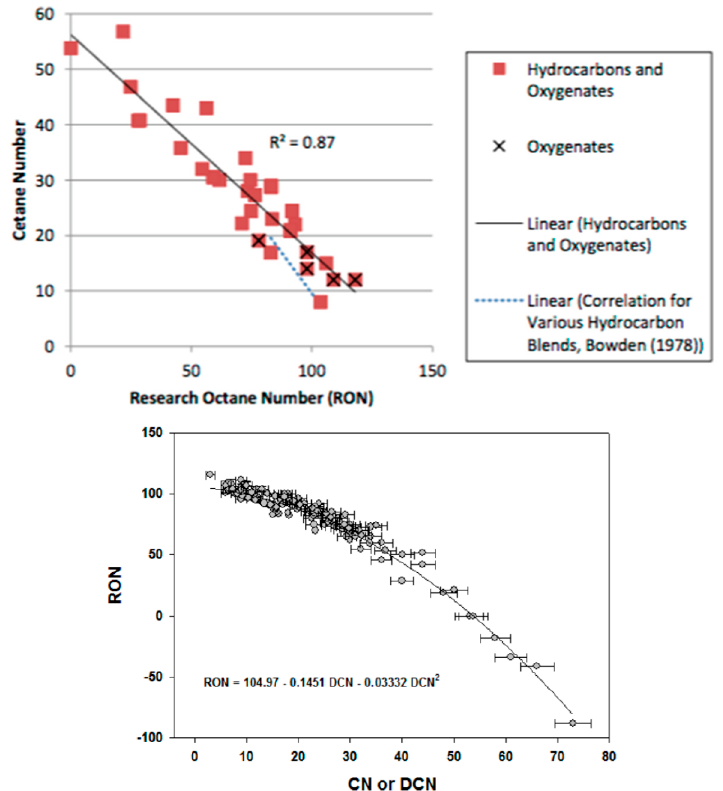
Figure 4. Relation between CN and RON for various oxygenate and hydrocarbon fuels (adapted from [39,40]).